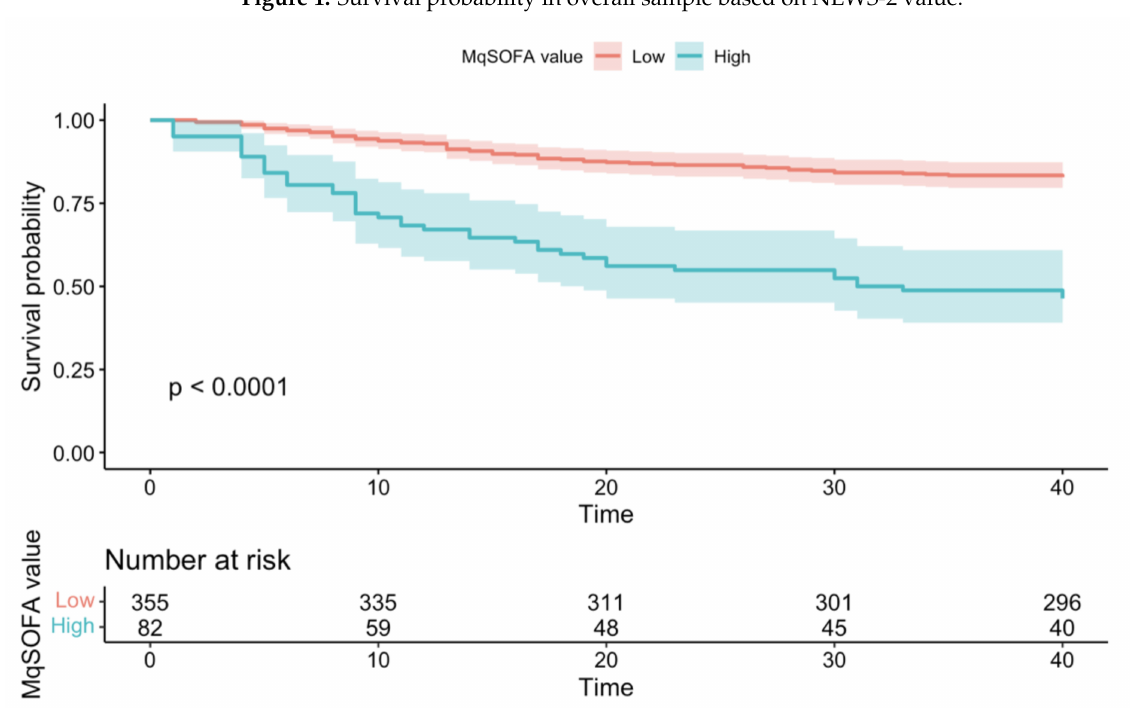
Figure 2. Survival probability in overall sample based on MqSOFA